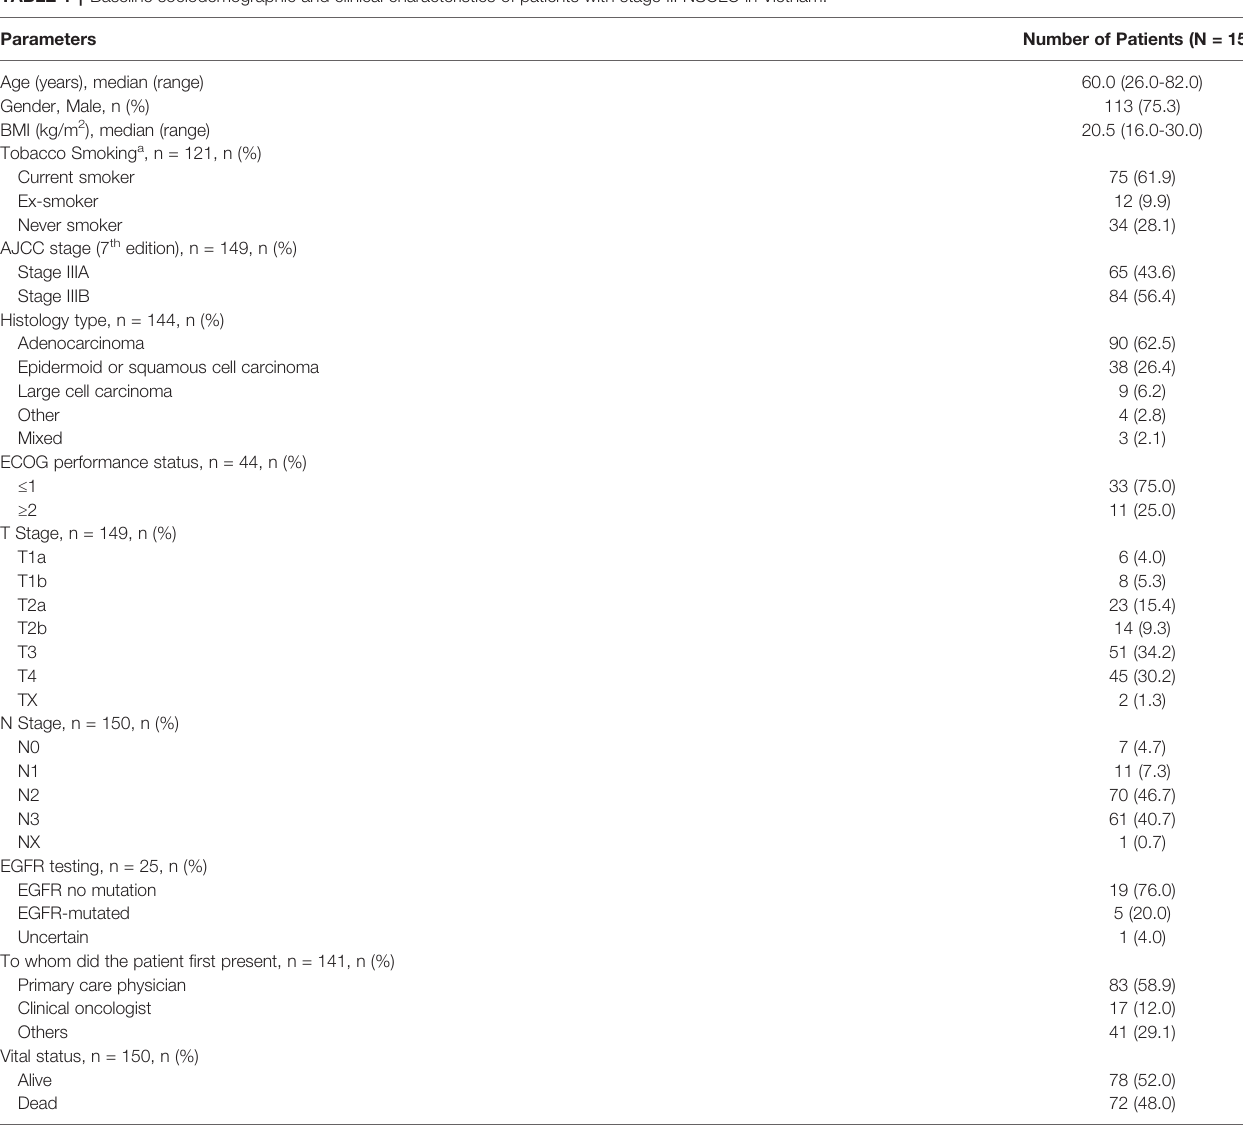
TABLE 1 | Baseline sociodemographic and clinical characteristics of patients with stage III NSCLC in Vietnam. Parameters Number of Patients (N = 150) Age (years), median